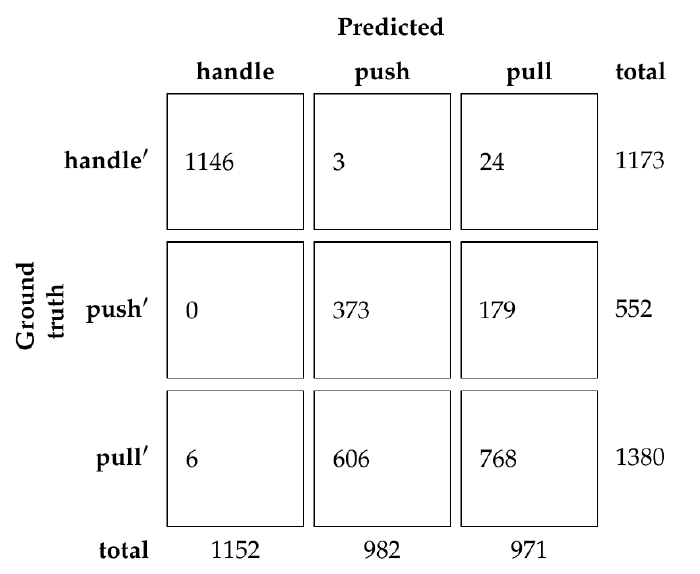
Figure 13. Confusion matrix for the human prediction survey on the dataset without human demon- stration.